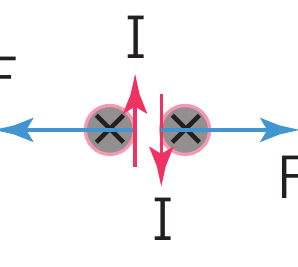
Fig. B1. Repulsive interaction between two closely spaced parallel field lines pointing into the plane and each carrying one electron in its lowest Landau level, LLL. Electron gyration is clockwise and confined to the circumference of the field line (red circles), produc- ing anti-parallel currents I red arrows). These currents give rise to repulsive forces F (blue arrows).